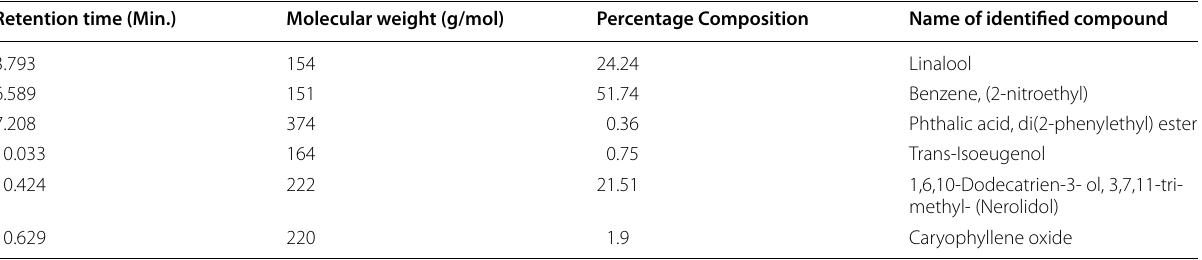
Table 1 Constituents in the essential oil of Dennettia tripetala Retention time